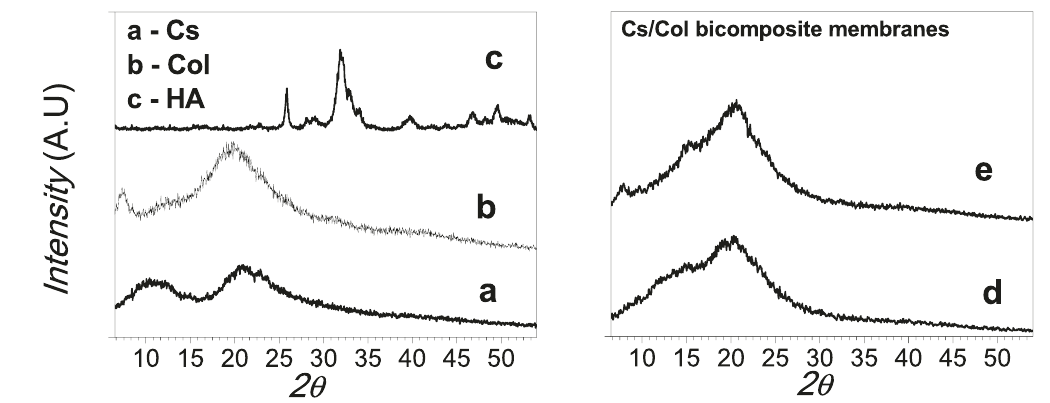
Fig. 1 X-rays diffractograms: a Chitosan (Cs). b Collagen (Col). c Hydroxyapatite (HA). d BCC1. e BCC2